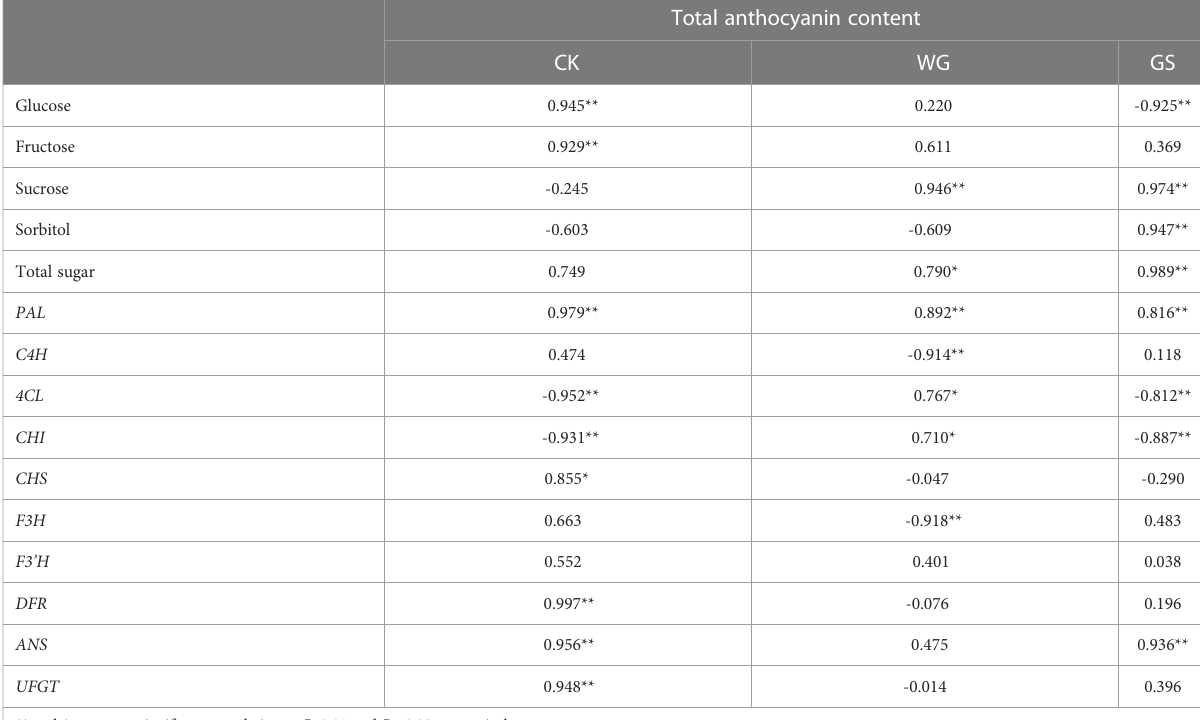
TABLE 5 Correlation between the anthocyanins content and sugar content and gene expression